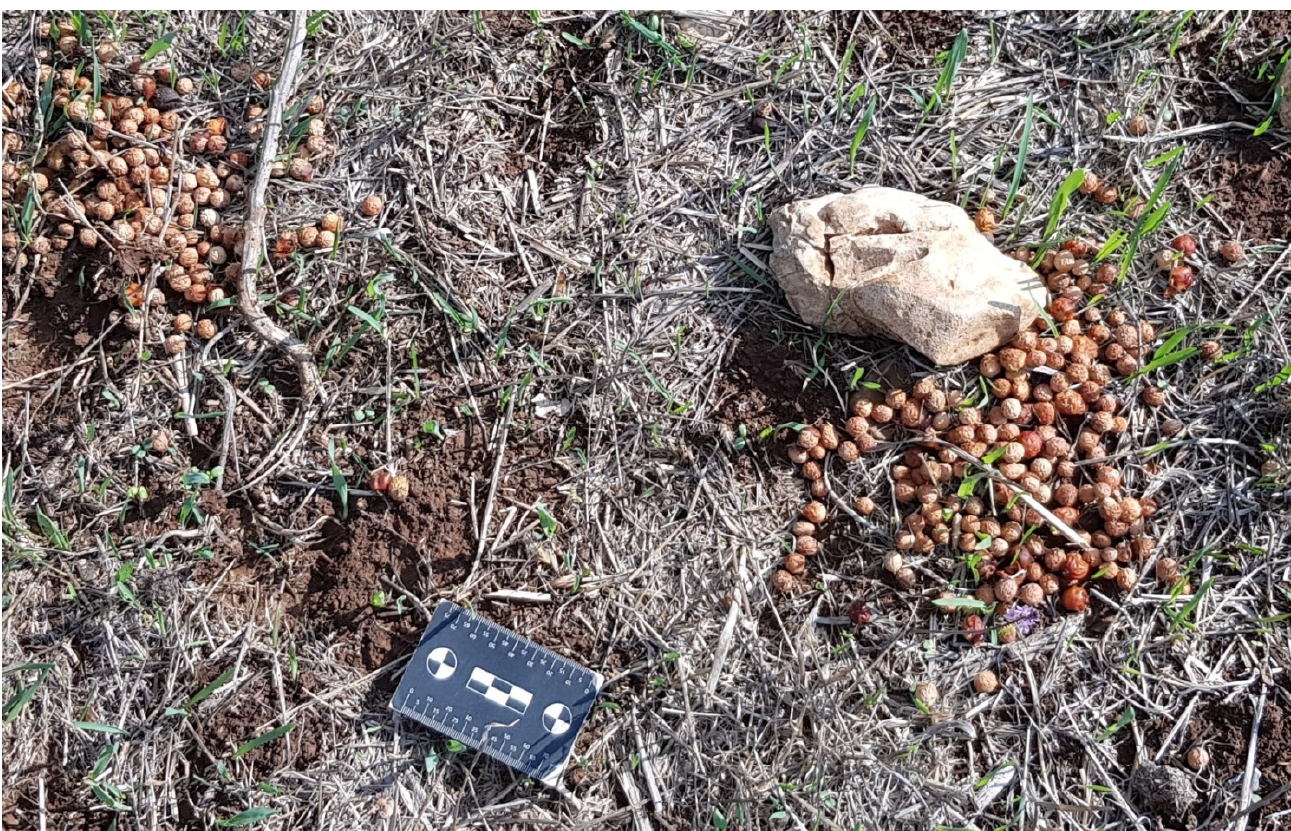
Figure 1. Indigestible fruit pits spat out by gazelles during resting and regurgitating while standing up. Such pits were removed from rumen contents before analyses. Photo by A.A.